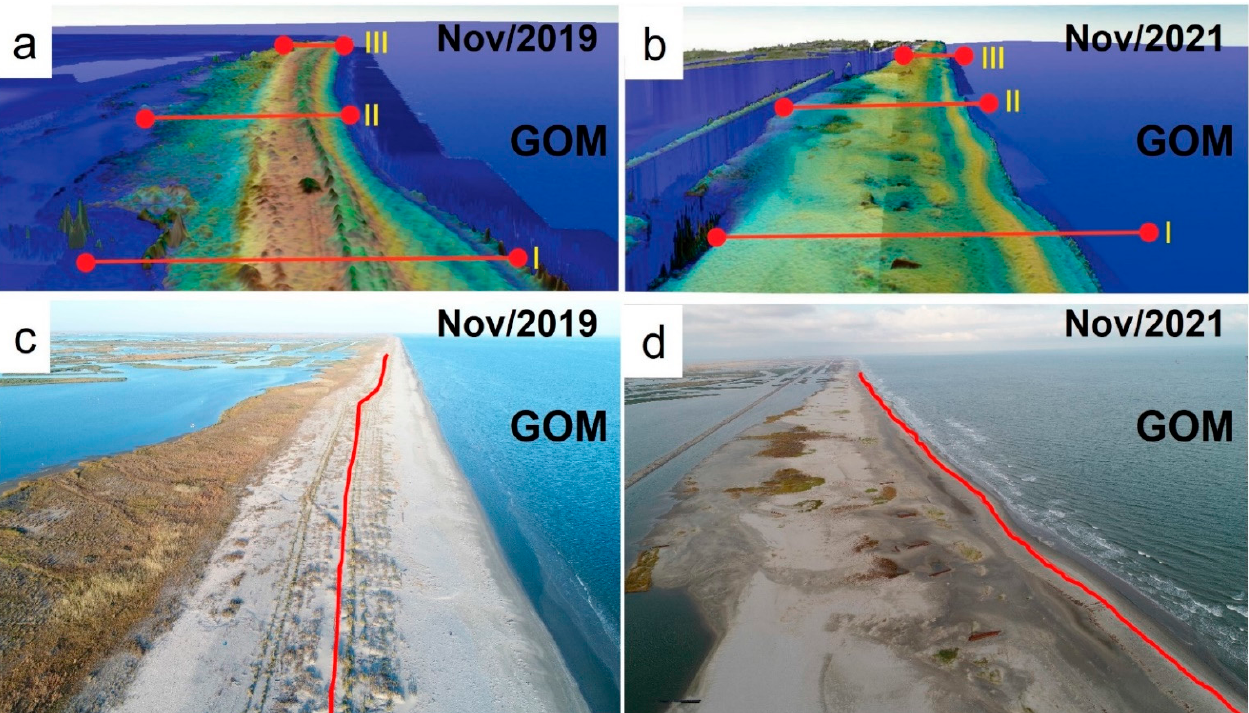
Figure 4. DEMs of the beach barrier in ( a ) 2019 and ( b ) 2021 (see location in Figure 1d). Drone images (taken during low-tide) of the studied beach barrier in ( c ) 2019 and ( d ) 2021. The red dots in ( a , b ) mark the fixed reference points that establish the three cross-shore profiles. The red lines in ( c , d ) mark the dune crest position in 2019.